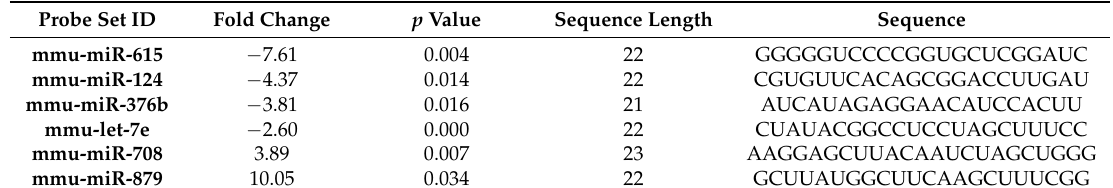
Table 1. Differentially-expressed miRNA (|fold change| ≥ 2 and p -value < 0.05).